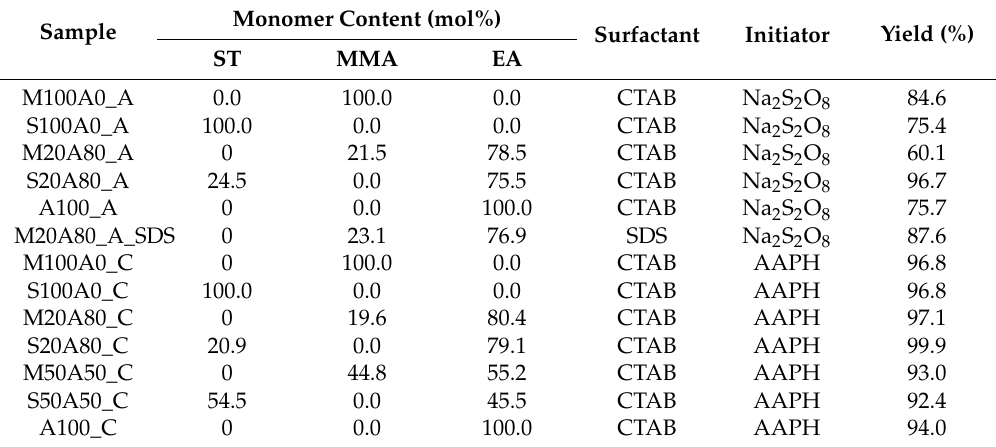
Table 1. Composition of co-polymers employed in the present study (monomer content from 1 H-NMR measurements described in